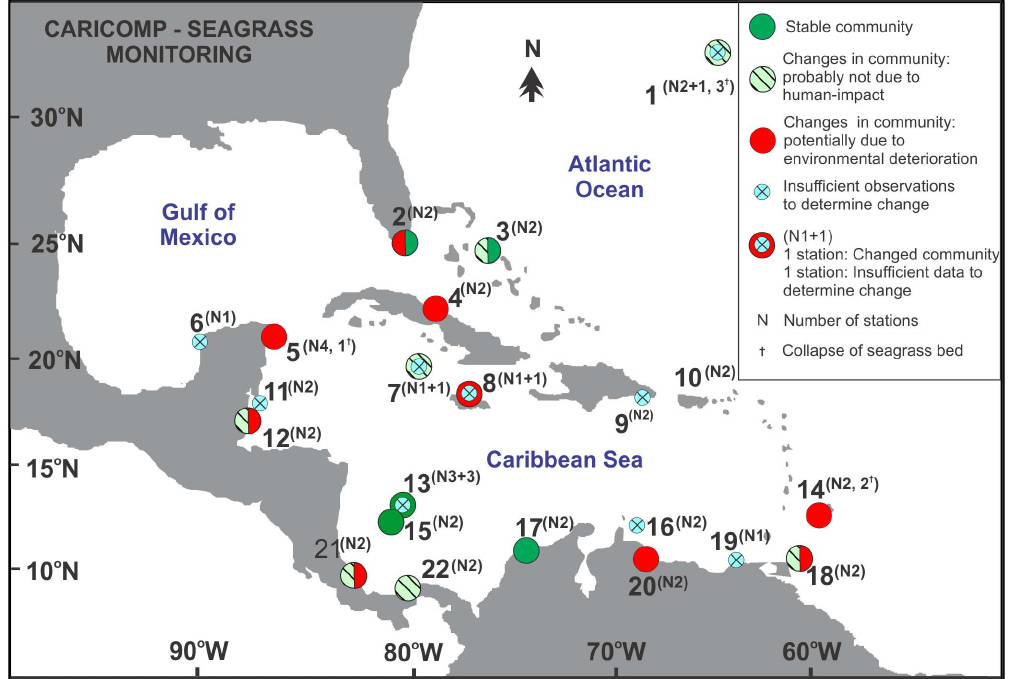
Figure 1. Map of CARICOMP seagrass sites, ordered according to latitude. 1. Bermuda, 2. USA-Long Key, 3. Bahamas-San Salvador, 4. Cuba- Cayo Coco, 5. Mexico-Puerto Morelos, 6. Mexico-Celestun, 7. Cayman Islands-Grand Cayman, 8. Jamaica-Discovery Bay, 9. Dominican